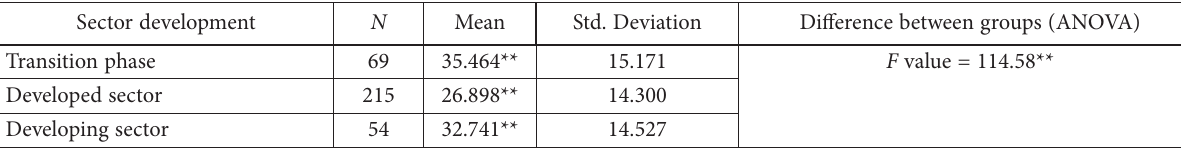
Table 11. Association between Sector Development and the incidence of under-invoicing (source: author’s calculation) Sector